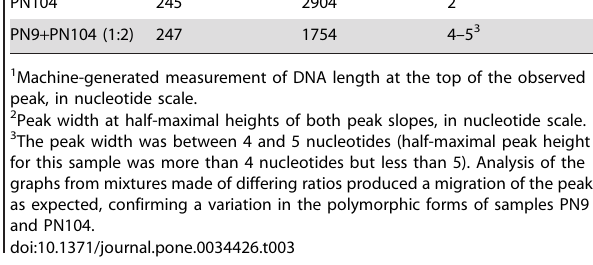
Mononucleotide repeat